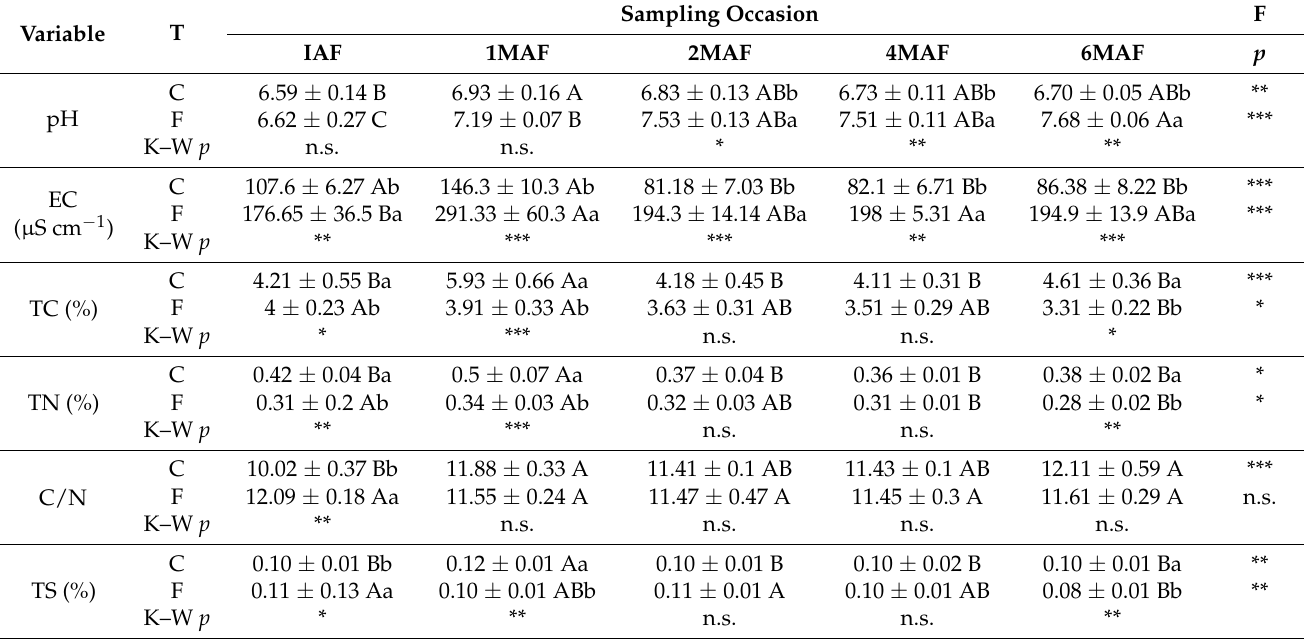
Table 3. Soil pH, electrical conductivity (EC), total nitrogen (TN), total carbon (TC), carbon–nitrogen ratio (C/N), and total sulphur (TS) in control (C) and fire (F) treatments (T) during the studied period (IAF, immediately after fire; MAF, months after fire) (mean ± standard deviation). Different letters indicate significant differences between sampling dates (uppercase letters) and treatments (lowercase letters). Kruskal–Wallis (K-W) (* p < 0.05, ** p < 0.01, *** p < 0.001, and n.s. non-significant at p < 0.05) results are shown for each comparison between treatments, and Friedman (F) ANOVA between sampling